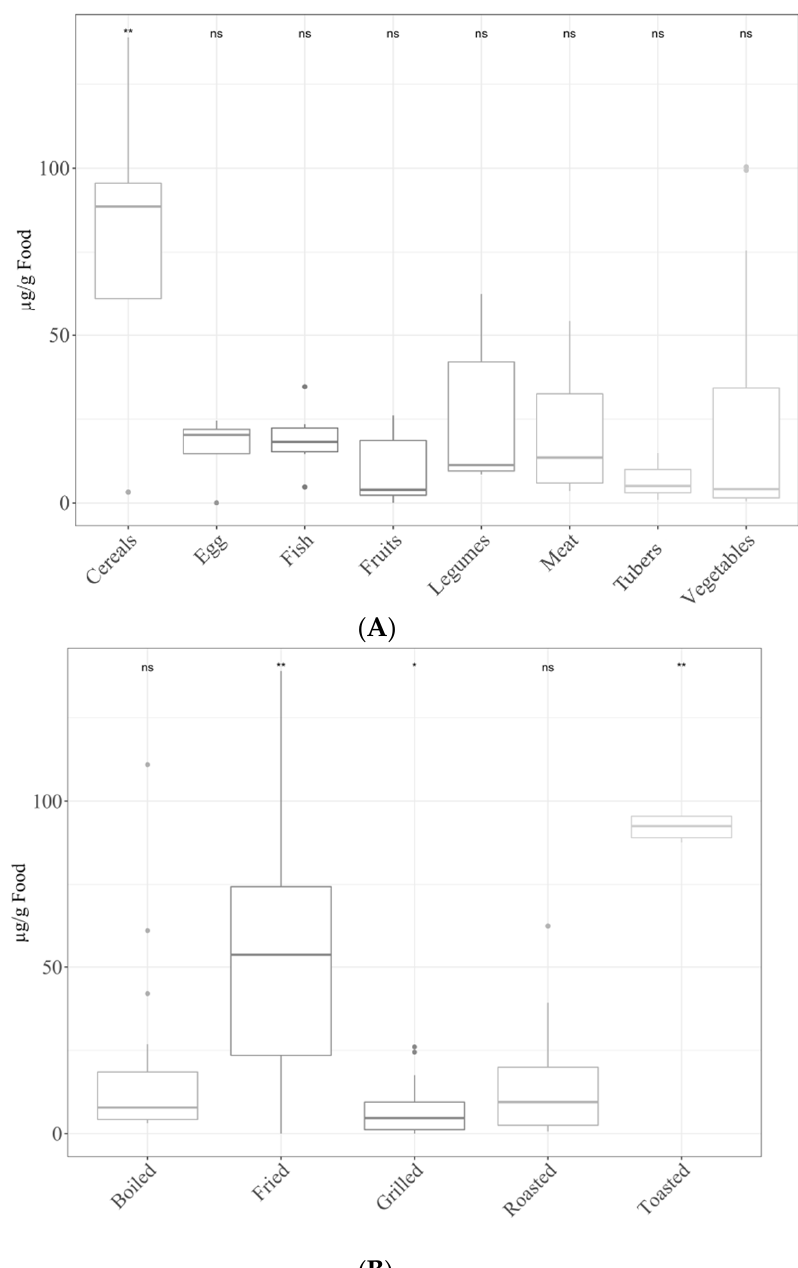
Figure 1. ( A ) Furosine levels in different food groups. Statical analysis was performed via Kruskal– Wallis test. Each of the groups were compared to the average of all of them (i.e., base-mean). Statistic labels: *: p < 0.05. **: p < 0.01, ns: not significant. ( B ) Furosine levels depending on the cooking applied. Statical analysis was performed via Kruskal–Wallis test. Each group was compared to the average of all of them (i.e., base-mean). Statistic labels: *: p < 0.05, **: p < 0.01, ns: not significant.